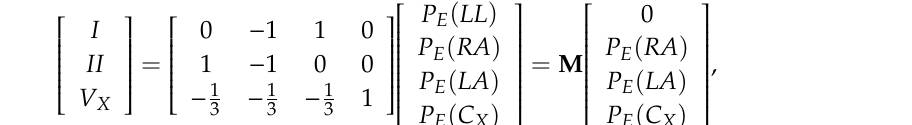
Figure 1. Acquisition of 12-lead ECG via a 10-electrode cable with standard IEC color coding, recording 8 independent leads I, II, V1-V6 (denoted as Vx) in the ECG device. The flow diagram shows the simulation of reversals between LL, RA, LA and one chest electrode (denoted as Cx) by conversion of the recorded leads ( I, II, Vx ) to reordered leads (ˆI, (cid:98) II, (cid:98) V X ) using the matrix transformations The specific example shows an identity S matrix that corresponds to the correct order of LL, RA, LA, Cx electrodes. Other estimates of the S matrix are presented on Figure 2 and Section 4.1 in the description of di ff erent examples for electrode